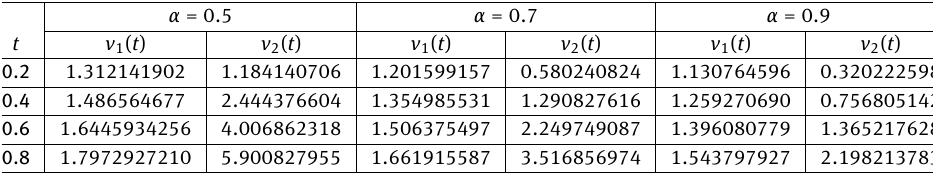
Table 1: Numerical values of ϕ 1 ( t ) and ϕ 2 ( t ) for α = 0.5, 0.7, 0.9 to Example